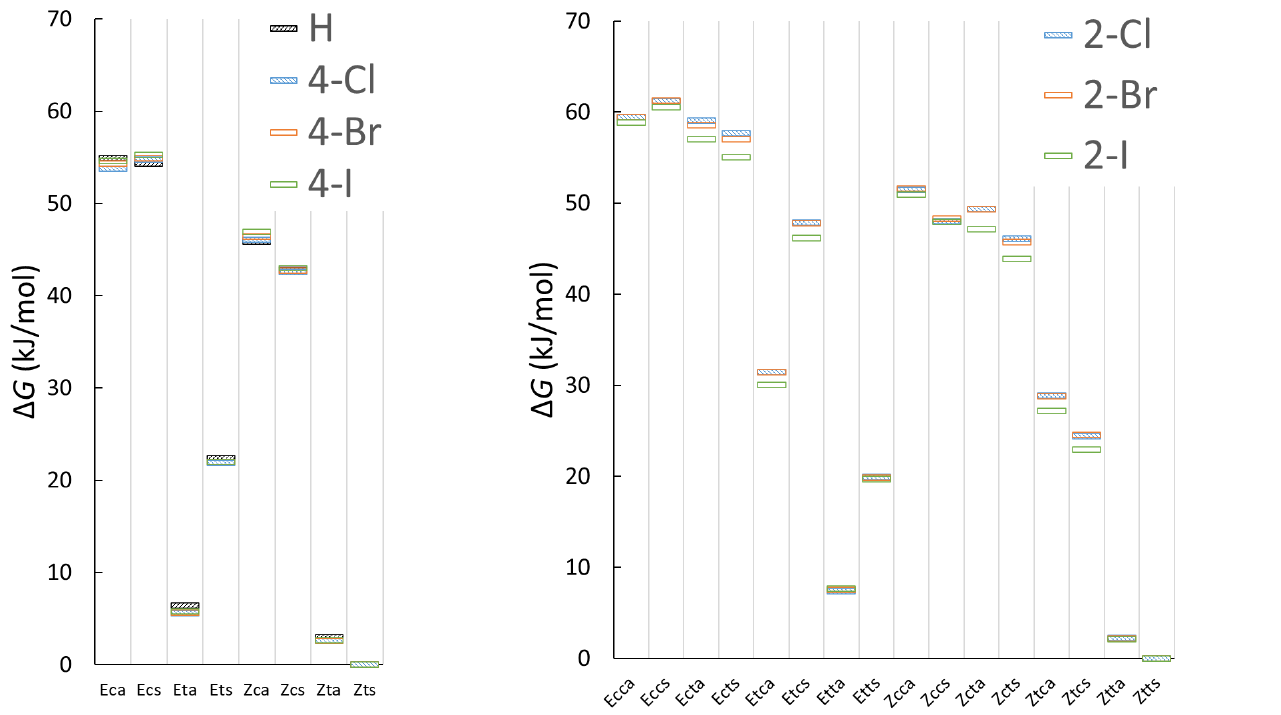
Figure 11. Relative free energy at 298 K of the minimum energy structures of 1 – 4 (left) and 5 – 7 (right) calculated at the ω B97M-D4/cc-pVTZ level. The vertical lines are just a guide for the eye.